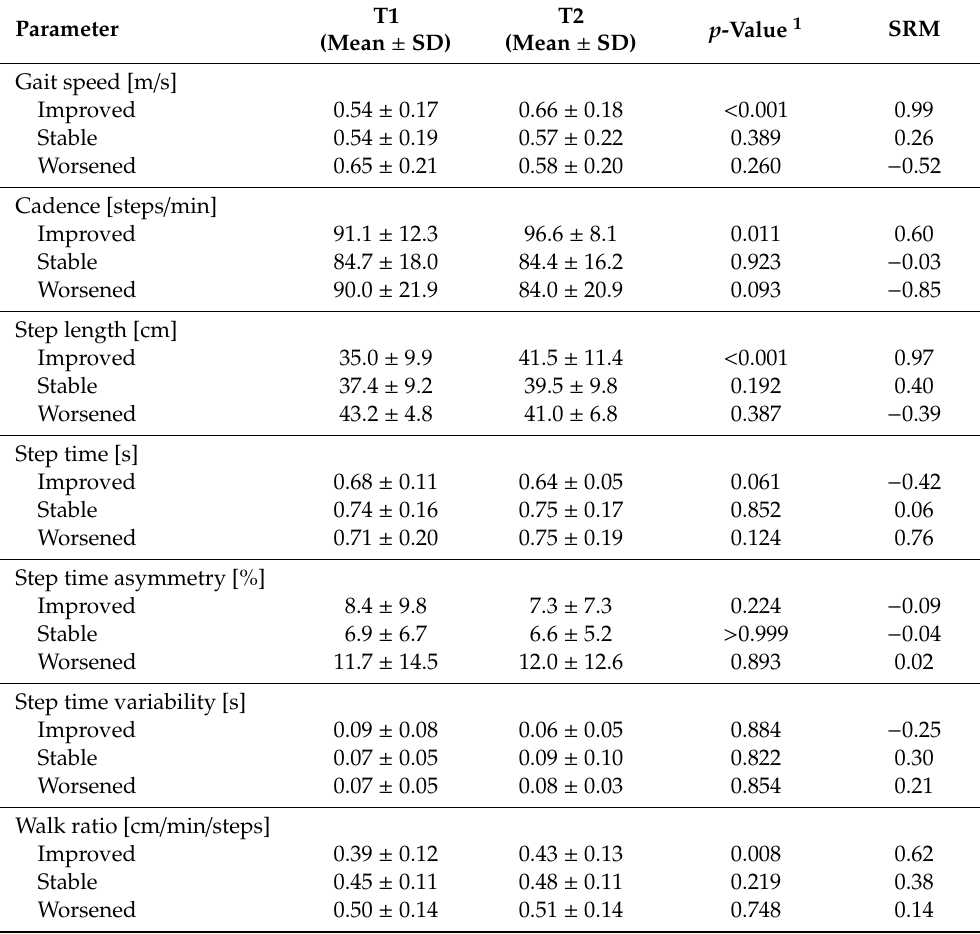
Table 4. Sensitivity to change of the DynaPort MT in improved ( n = 22), stable ( n = 12) and worsened patients ( n =